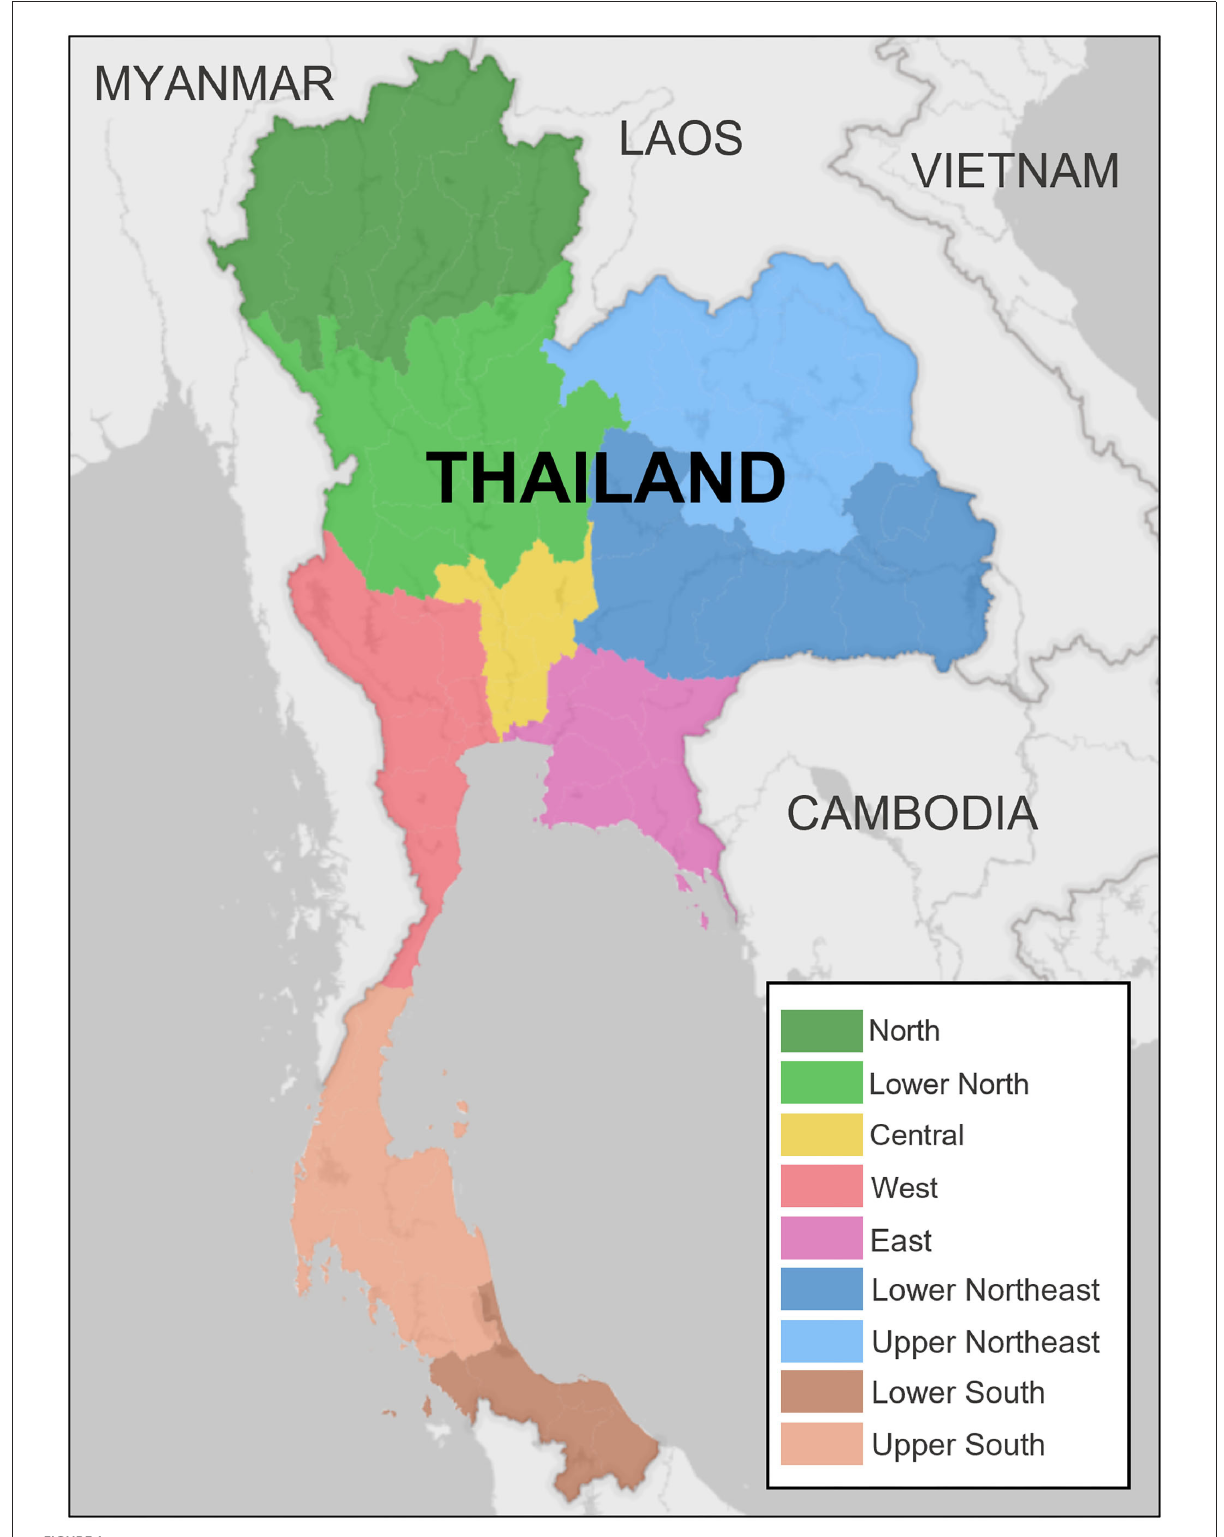
FIGURE1 Map of Thailand illustrating the geographical distribution of the study area. Data used for the analysis involved the registered movement of dairy cattle across 110 districts from 32 of 77 provinces in seven of the nine regions of Thailand, including north, lower north, central, west, east, lower northeast, and upper